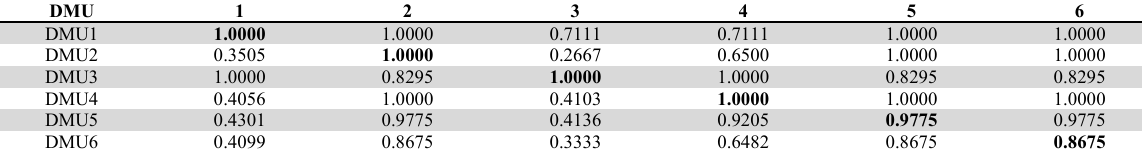
RCA cross-efficiency matrix (RCA-CEM) of six nursing homes DMU 1